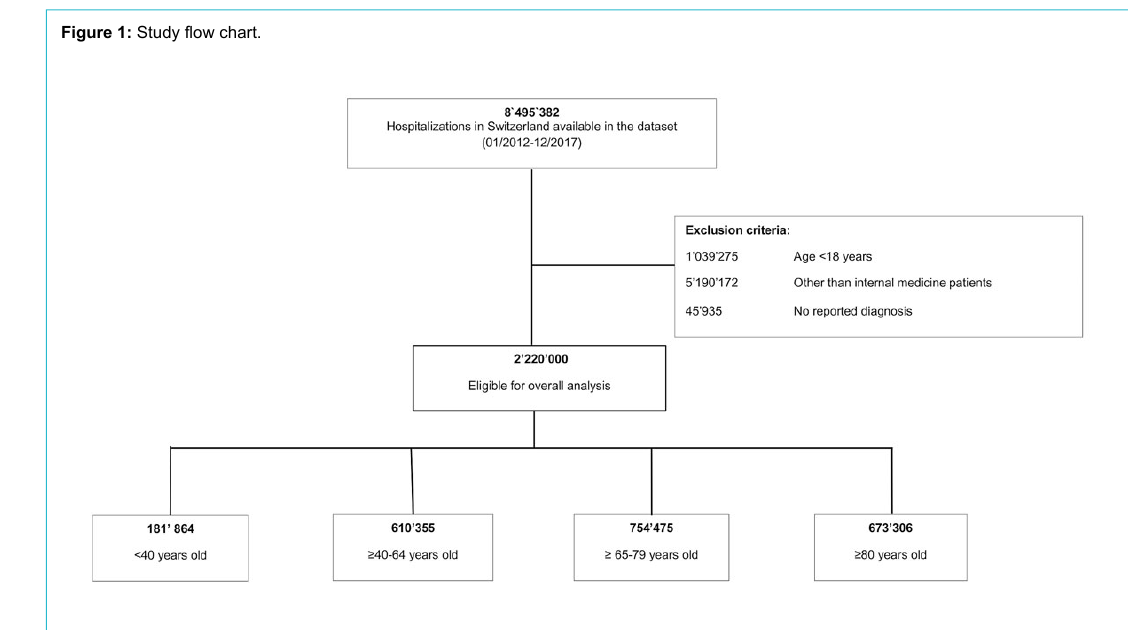
Figure 1: Study flow